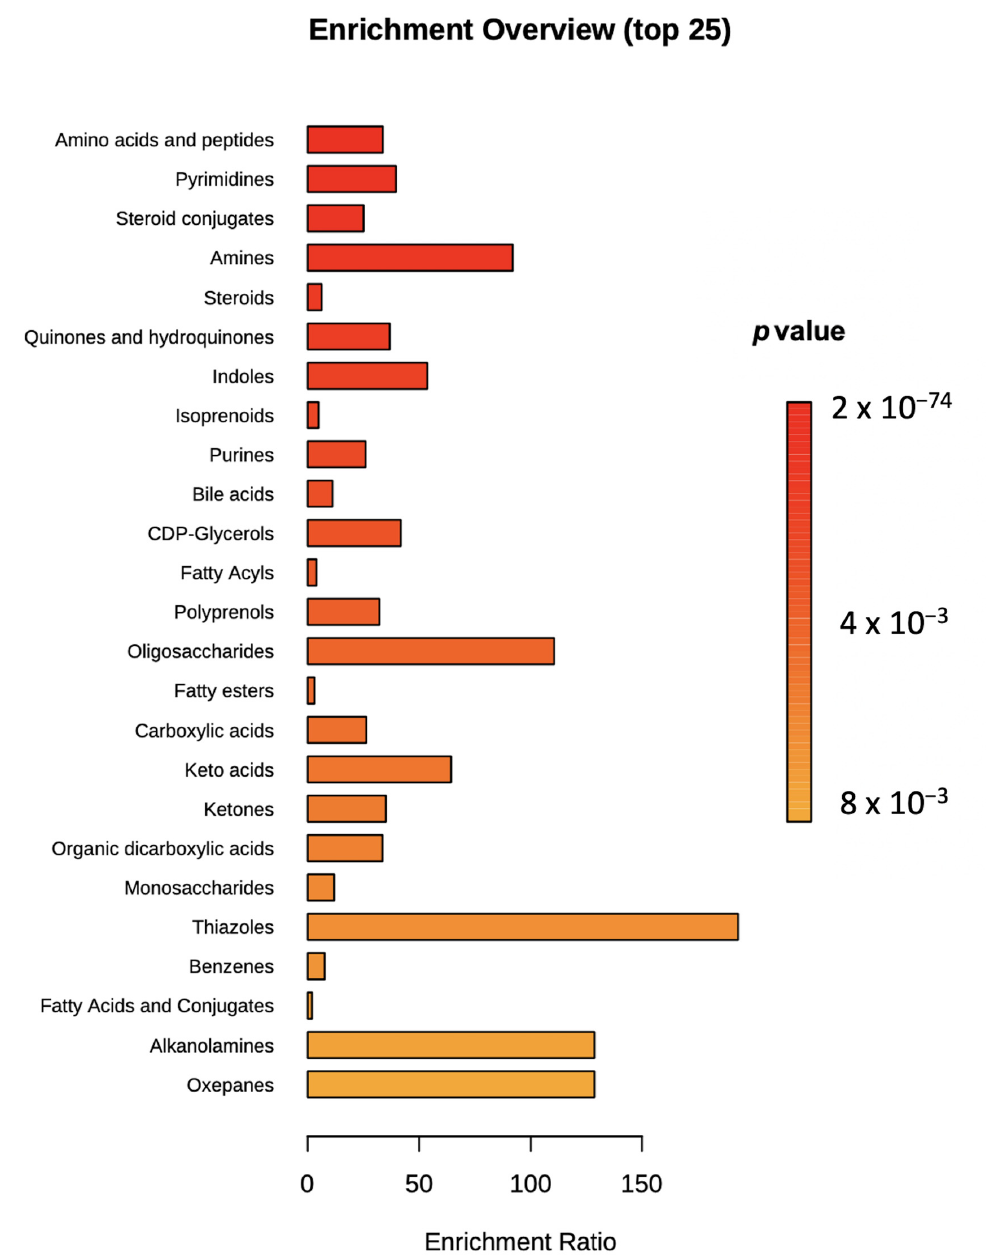
Figure 4. Significant metabolite set enrichment graph considering those milk metabolites annotated by UHPLC-HRMS and passing one-way ANOVA ( p <